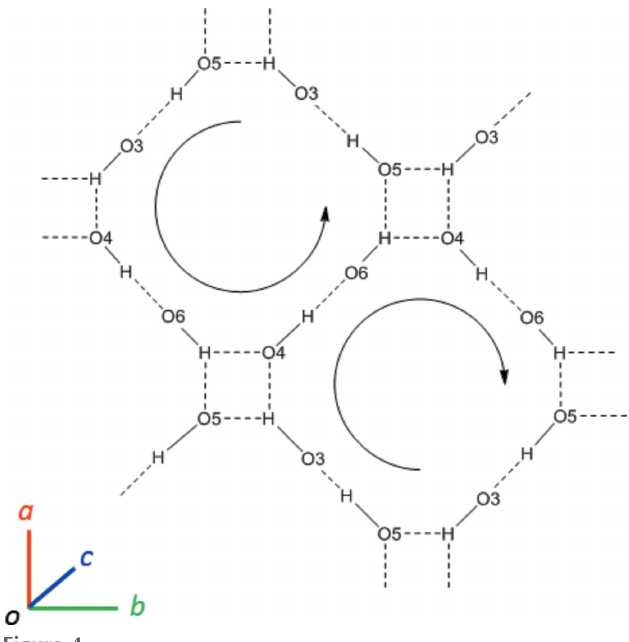
Figure 4 Hydrogen-bonding pattern in the crystal structure of